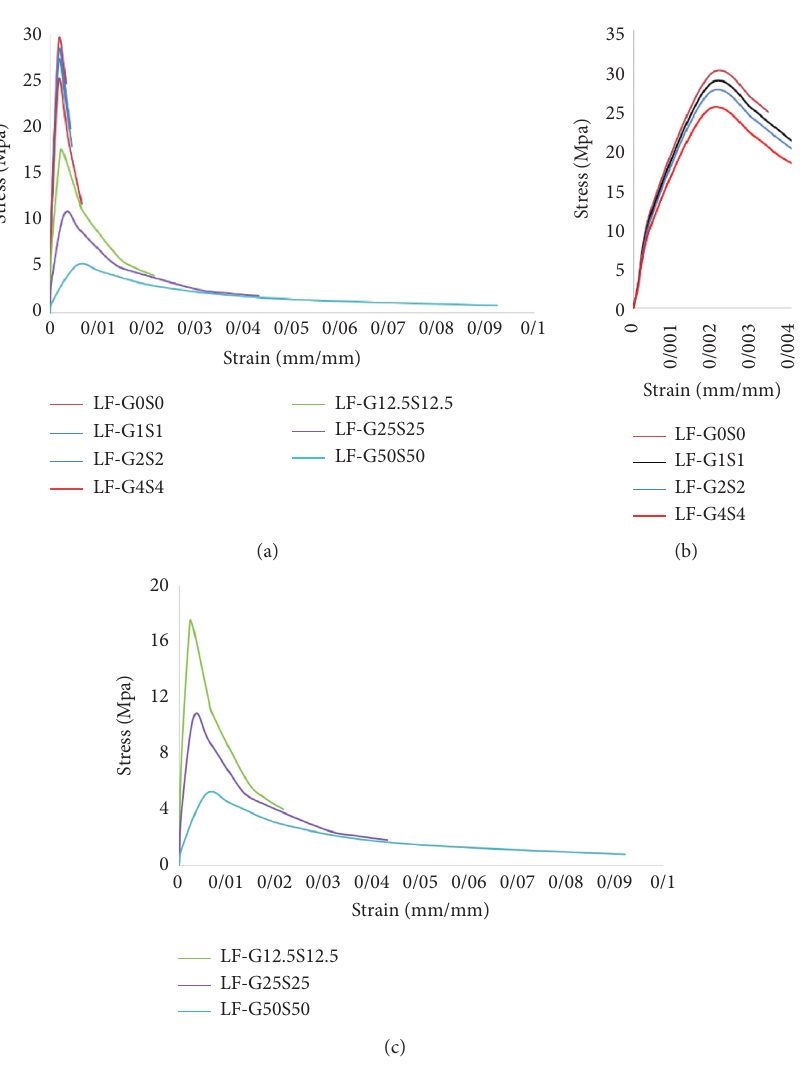
Figure 7: Failure types of HSRC specimens under compression error rate of the extracted functions. The results are shown in Table 6. Comparison of the extracted RF-functions results and HSRC specimens test results is presented in Figure 12.